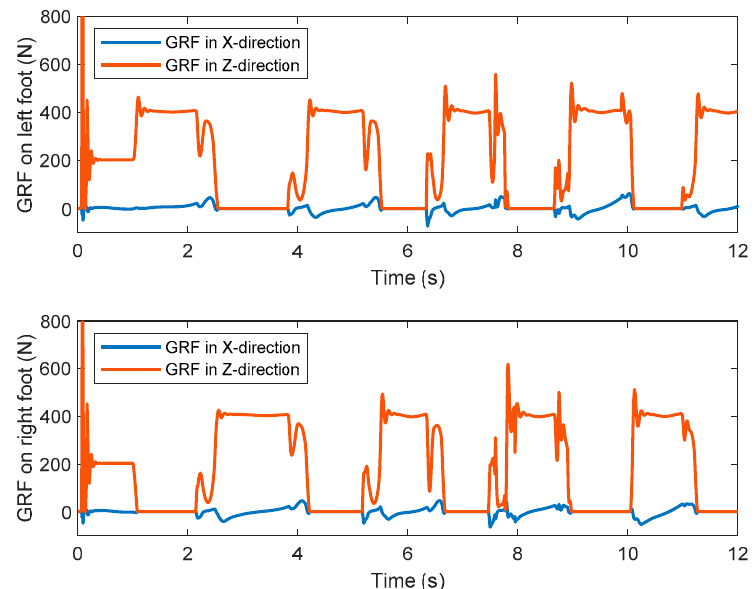
Figure 22. The ground reaction forces of the left and right feet in the second simulation.